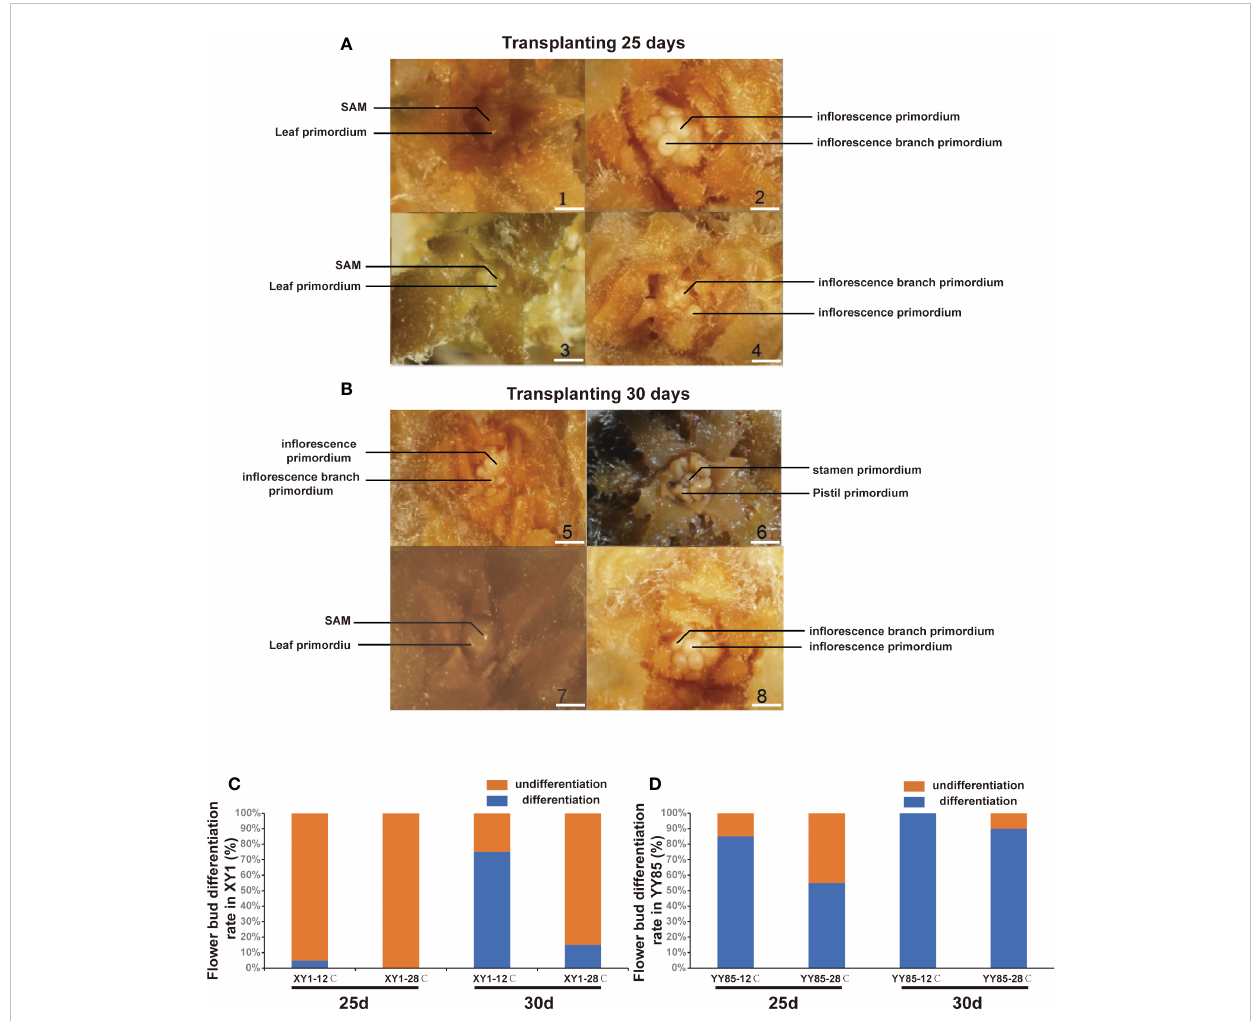
FIGURE 1 Microscope observation of cold stress induced fl ower bud differentiation. (A) and (B) Phenotype characteristic of tobacco stem tips under microscope. XY1 under 12°C treatment (1 and 5); YY85 under 12°C treatment (2 and 6); XY1 under 28°Ctreatment (3 and 7); YY85 under 28°C treatment (4 and 8). Bar = 1 mm. (SAM means shoot apical meristem). (C) and (D) The fl ower bud differentiation rate of XY1 and YY85 under cold- stress treatment. 20 samples of each treatment were collected for observation, and the experiment was repeated